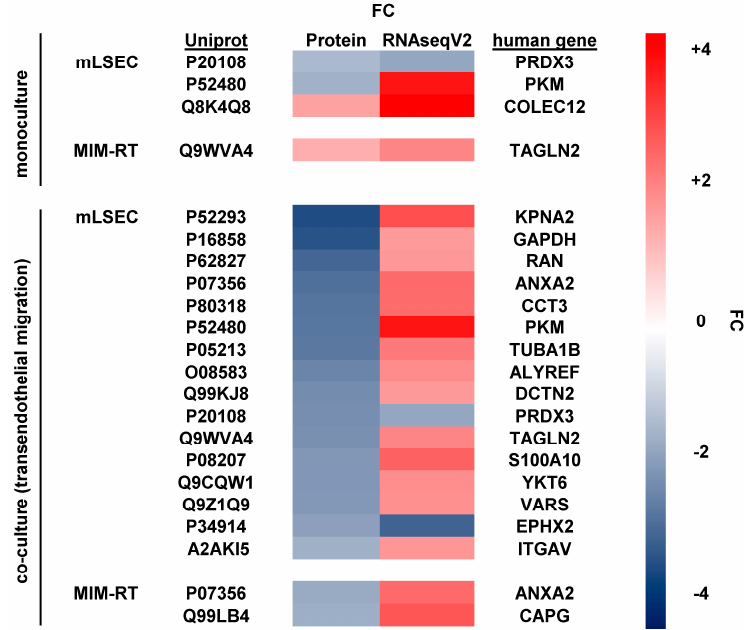
Figure 4. Molecular changes at the protein level in mLSECs and MIM-RT cells, as determined by mass spectrometry compared to mRNA levels of hepatocellular carcinoma (HCC) patients. The dataset RNAseqV2 from the TCGA, showing significant changes in vessel invasion and survival, was used for comparison. Displayed are targets with significant influence on the overall survival of HCC patients. Upper panel, mono-cultures of mLSECs or MIM-RT cells. Lower panel, mLSECs or MIM-RT cells analyzed during transmigration. FC, fold change.